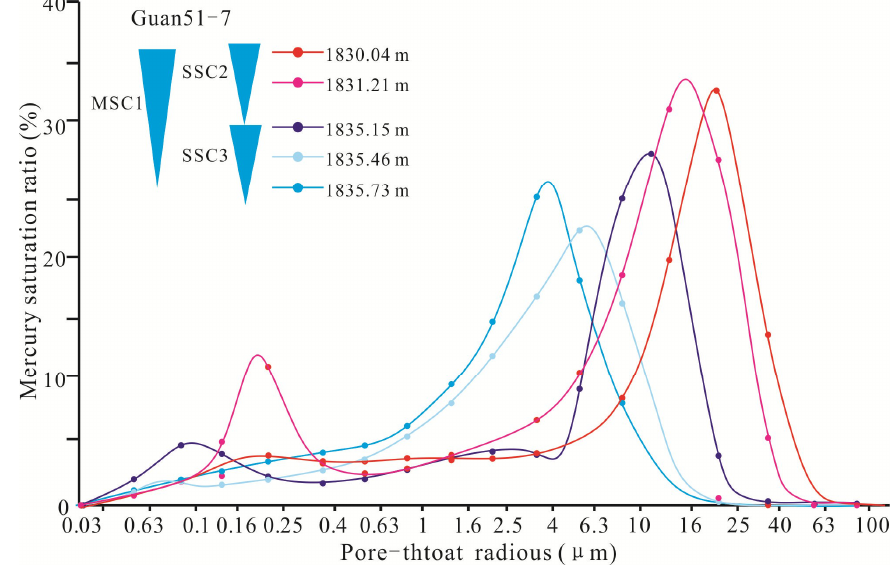
Figure 14. Pore throat size distributions by PMI of the samples in MSC1.